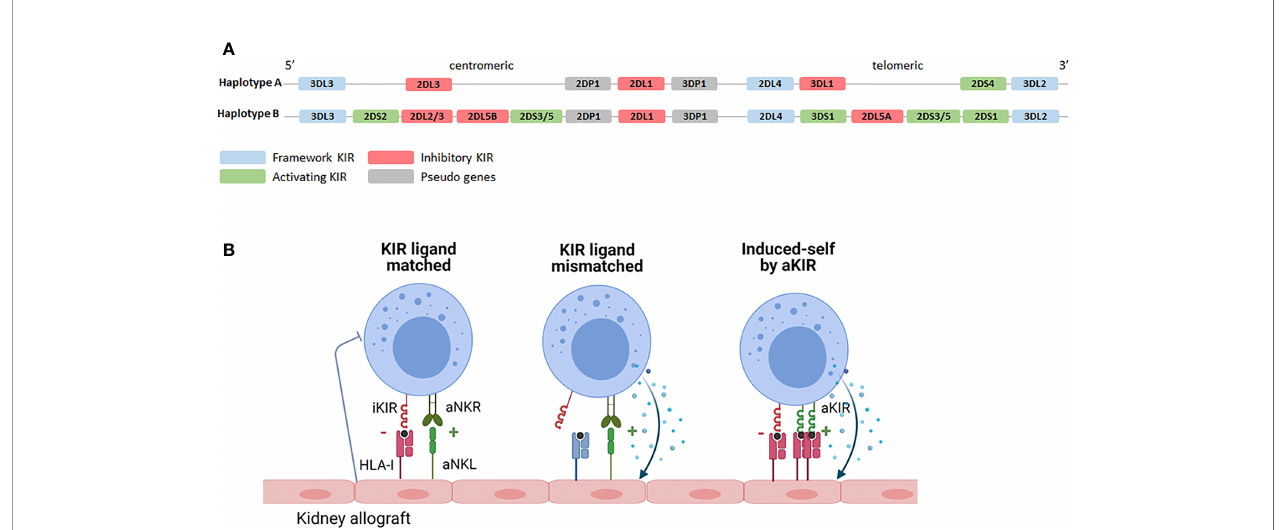
FIGURE 2 | KIR haplotypes and the potential effects of KIR-HLA interaction. (A) Based on the KIR gene content two haplotypes can be distinguished. The A haplotype containing KIR2DS4 as the only activating receptor and the B haplotype containing multiple combinations of activating- and inhibitory KIR genes. Depending on the exact combination of KIR genes, multiple different B haplotypes are known (https://www.ebi.ac.uk/ipd/kir/sequenced_haplotypes.html). (B) Recipient NK cells may encounter their HLA class I ligands on the kidney allograft (KIR ligand match) or not (KIR ligand mismatch). Even in the presence of class I ligand, stress- or infection associated ligands for activating receptors, including activating KIR, on the allograft can trigger NK cell cytotoxicity (induced-self by aKIR). iKIR, inhibitory killer immunoglobulin-like receptor; aKIR, activating killer immunoglobulin-like